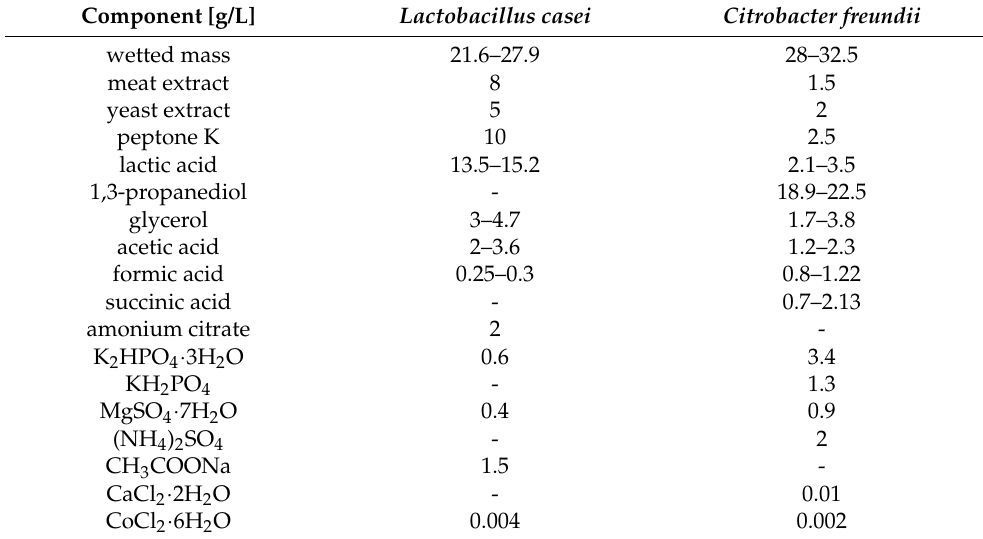
Table 1. The compositions of post-fermentation broths with Lactobacillus casei and Citrobacter freundii